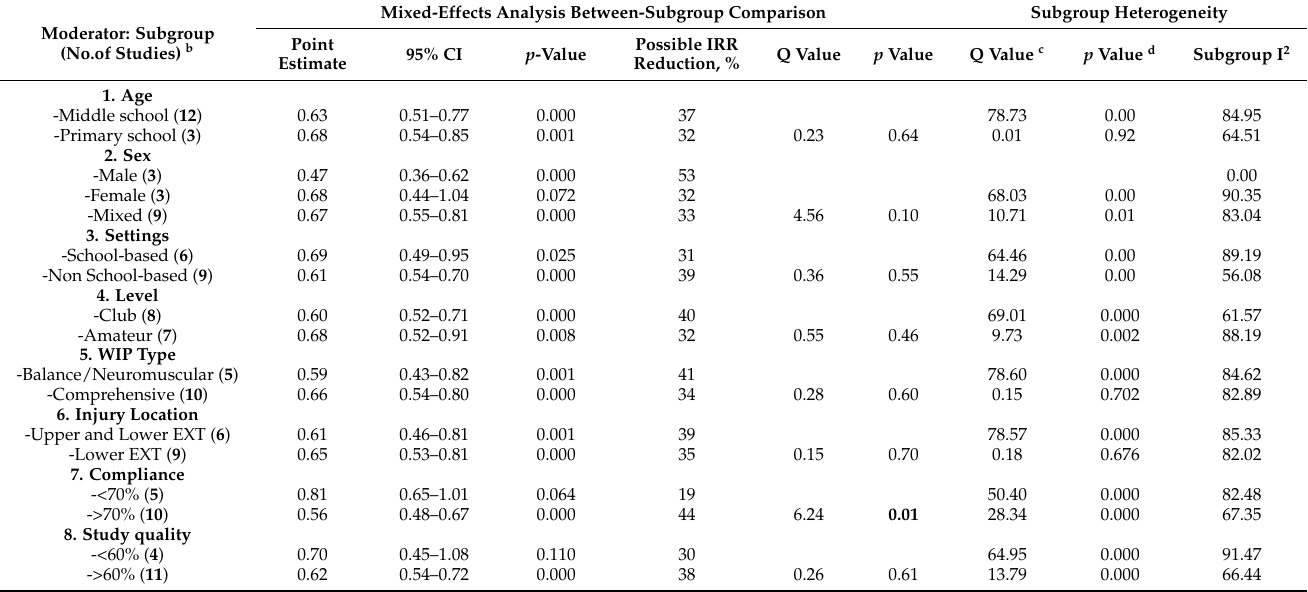
Table 4. Subgroup Analyses According to Identified Moderating Factors a